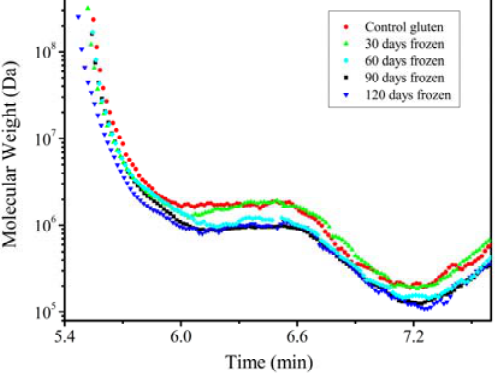
Figure 4. Effect of frozen storage time on the molecular weight of the wheat gluten